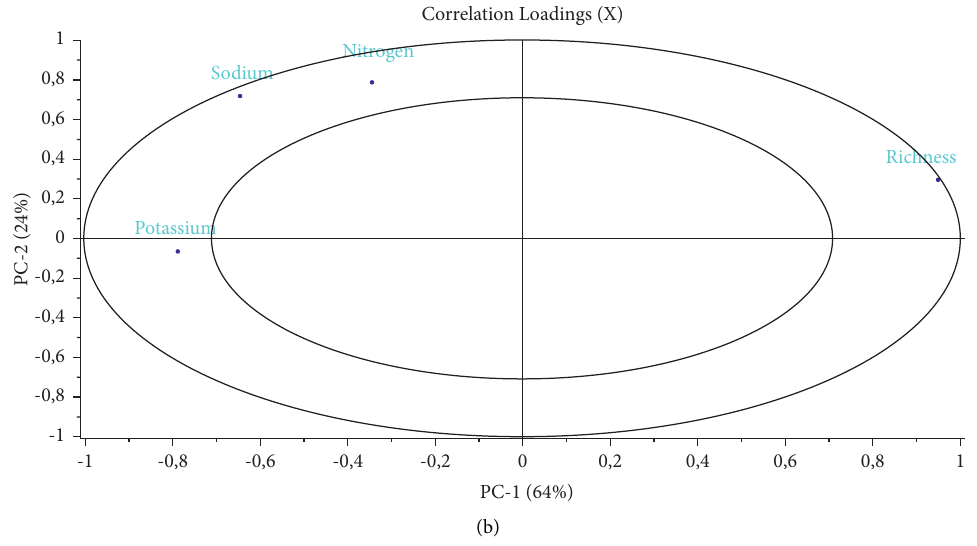
Figure 3: Correlation loading of beet quality parameters: (a) in the raw state; (b) on standardized centered